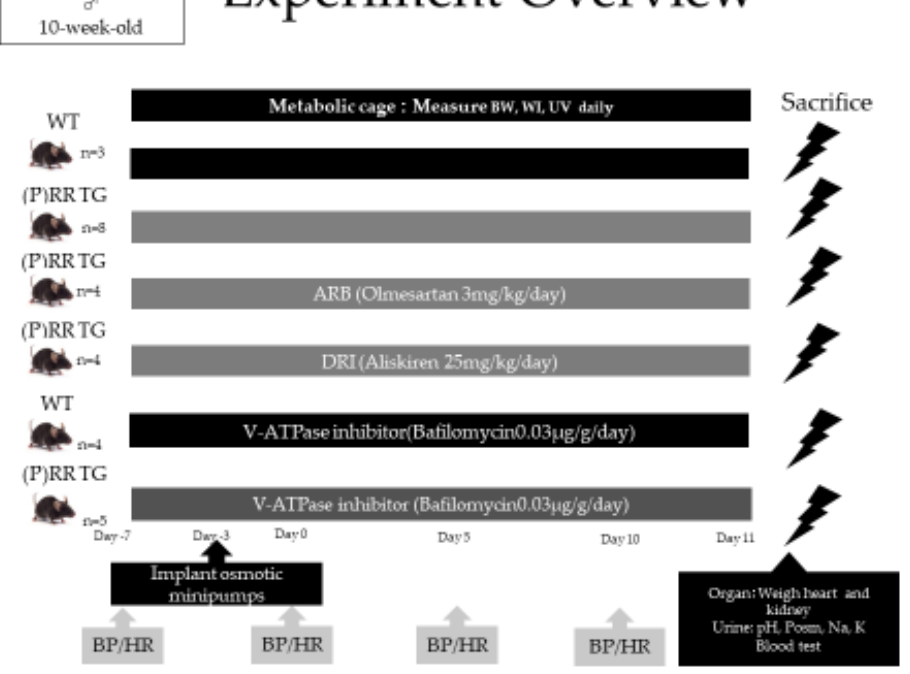
Figure 4. Experimental overview is shown. WT: wild type; (P)RR TG: (P)RR transgenic mice; BW: body weight; WI: water intake; UV: urine volume; ARB: angiotensin receptor blocker; DRI: direct renin blocker; BP: blood pressure; HR: heart rate. Table 1. Summary of body weight and kidney weight of mice.